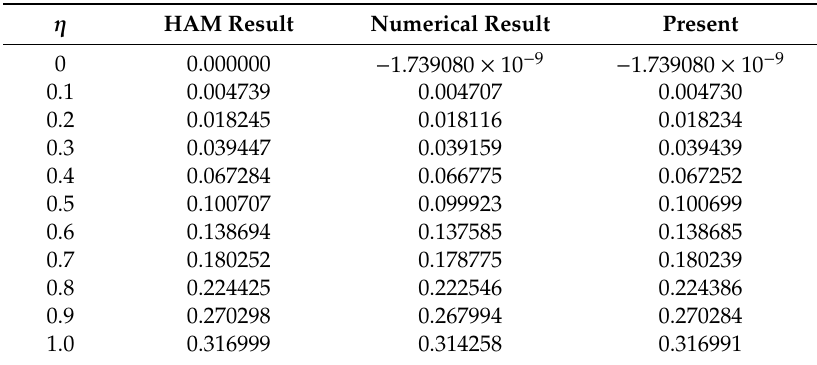
Table 4. Comparative values between the numerical and analytical solution (HAM) for f ( η ) versus varied estimates of η with Zahir et al.